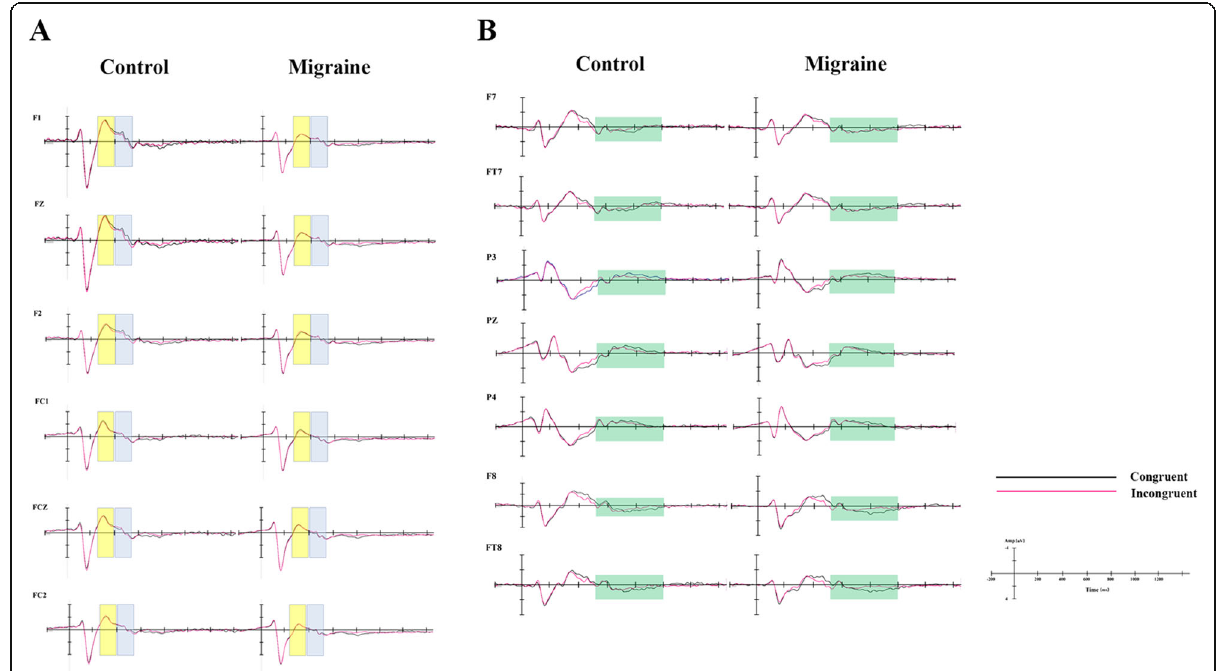
Fig. 3 The grand averaged ERPs elicited by task stimuli in patients and controls, respectively. a Grand average ERP waveforms recorded at six frontal midline electrodes (F1, FZ, F2, FC1, FCZ, FC2) evoked by congruent tasks (black lines) and incongruent tasks (red lines), with the yellow and blue boxes referred to the early MFN and late MFN respectively. b Grand average ERP waveforms recorded at three regions (left frontal, right frontal and parietal regions) evoked by congruent tasks (black lines) and incongruent tasks (red lines), with the SP component marked by green boxes